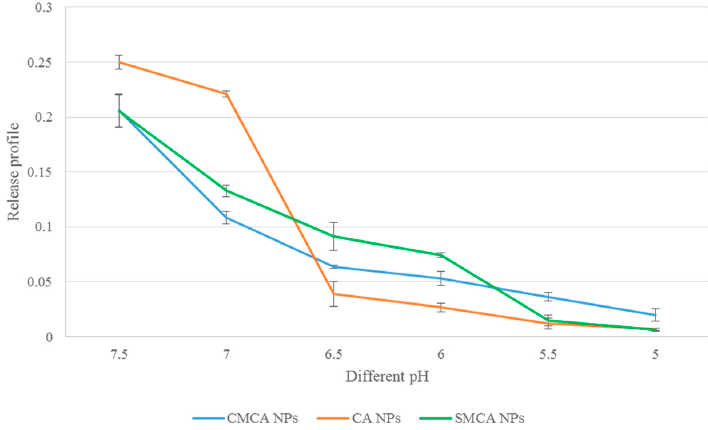
Figure 13. pH-dependent release of CA, CMCA and SMCA NPs.